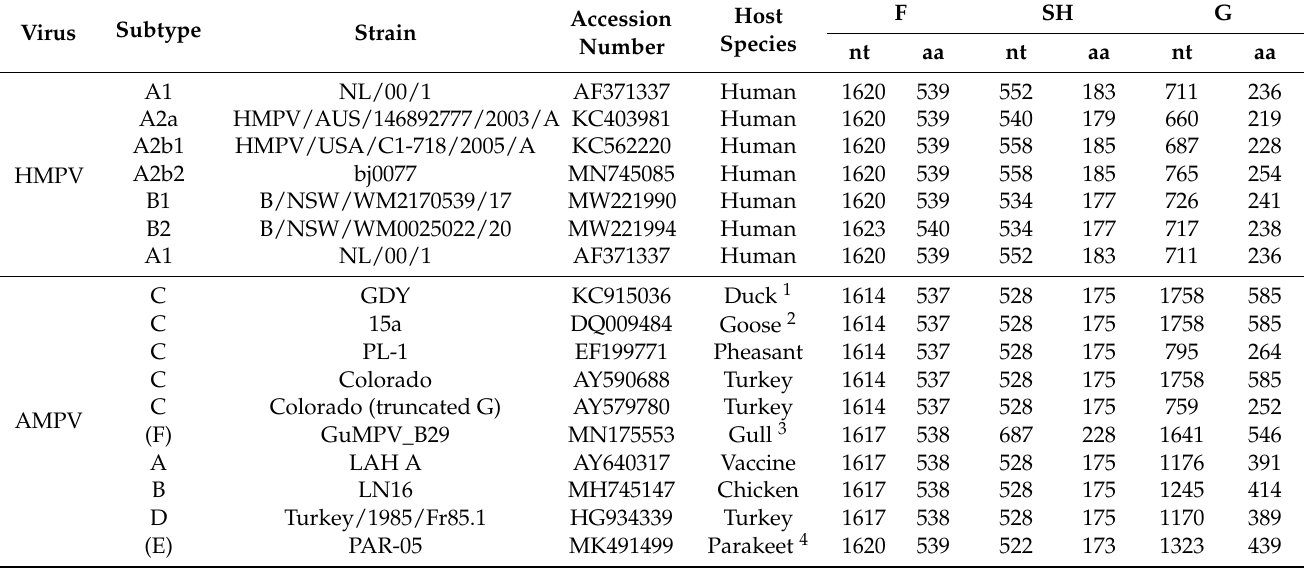
Table 1. Nucleotide (nt) and amino acid (aa) length of metapneumovirus